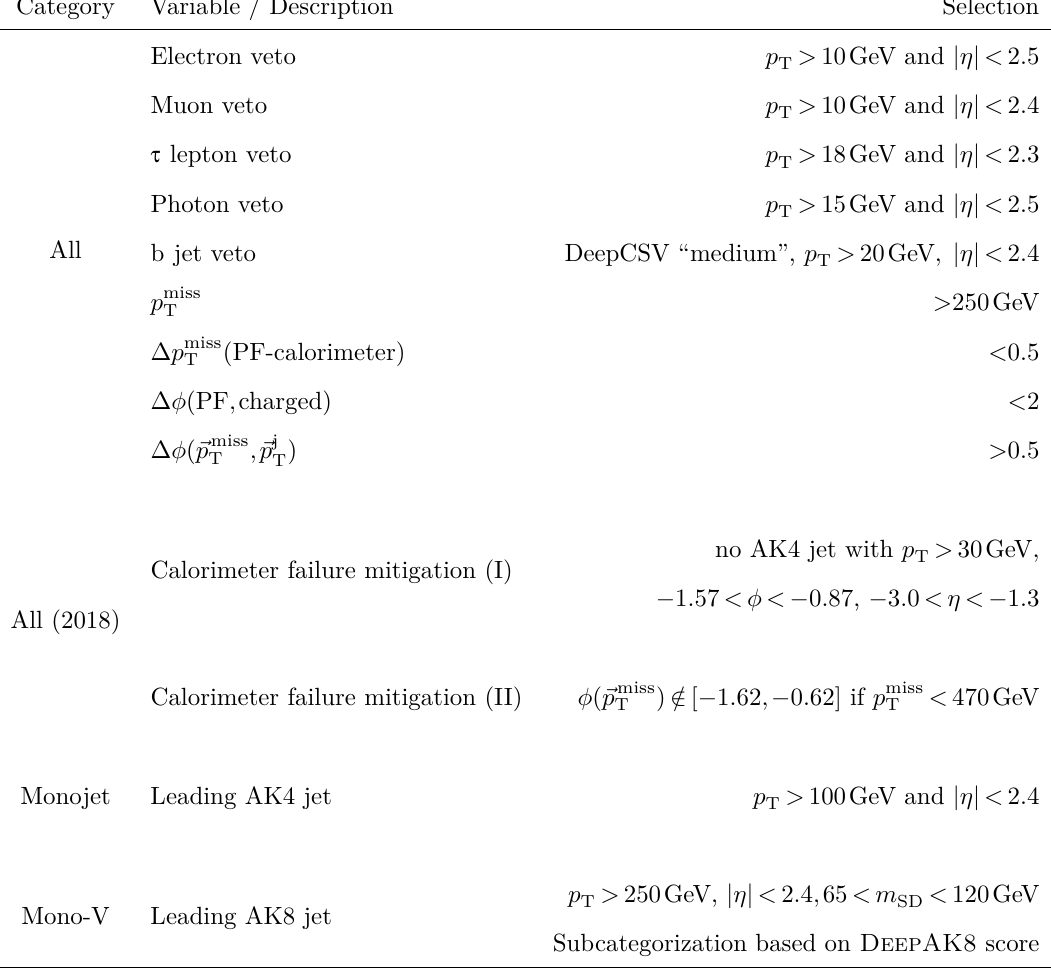
Table 1 . Summary of the common selection requirements for mono- V and monojet categories. For the control region selections, the requirements on p miss equivalent selections based on the hadronic recoil, which is calculated as the vectorial sum of the and the respective lepton or photon transverse momenta used to define the control region ~p miss T selection. The ∆ p miss ( PF-calorimeter ) and ∆ φ (PF , charged ) requirements are always evaluated T based on p miss , and not the hadronic T